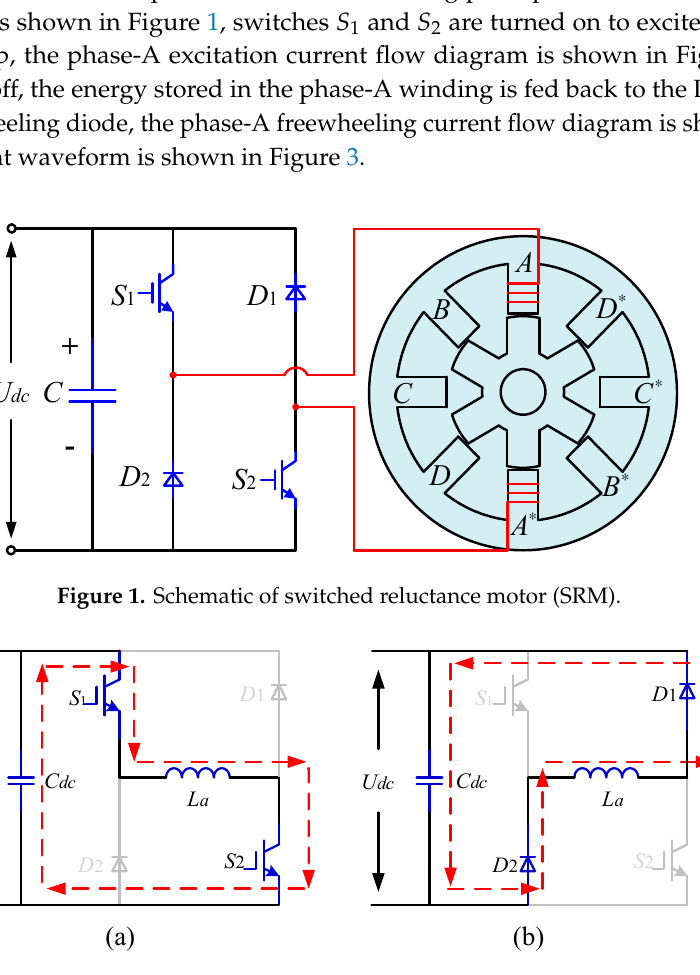
Figure 2. Operation modes of the asymmetrical half-bridge converter. ( a ) Excitation state. ( b ) Demagnetization